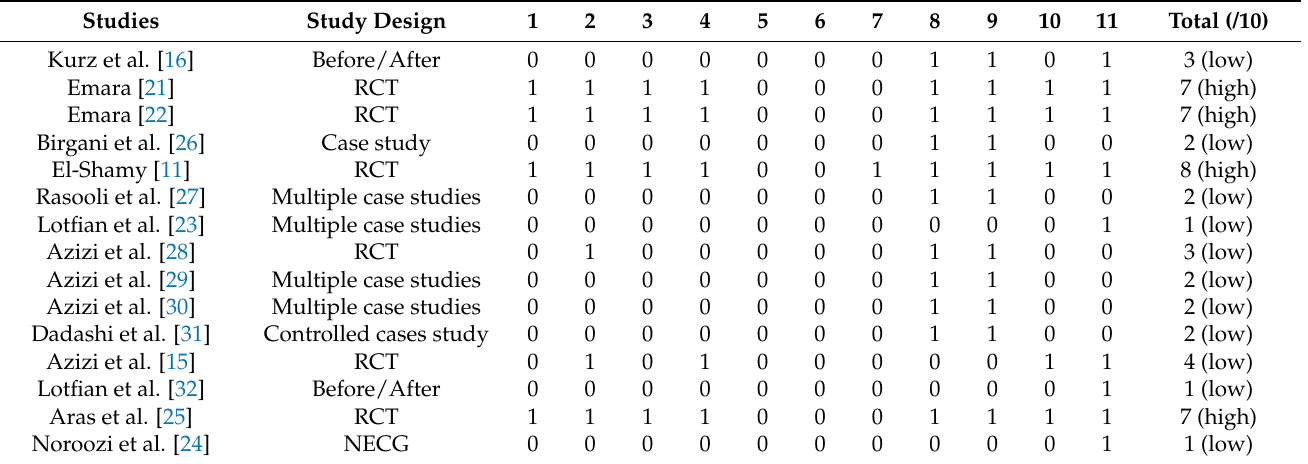
Table 1. Results of methodological quality of articles using the PEDro